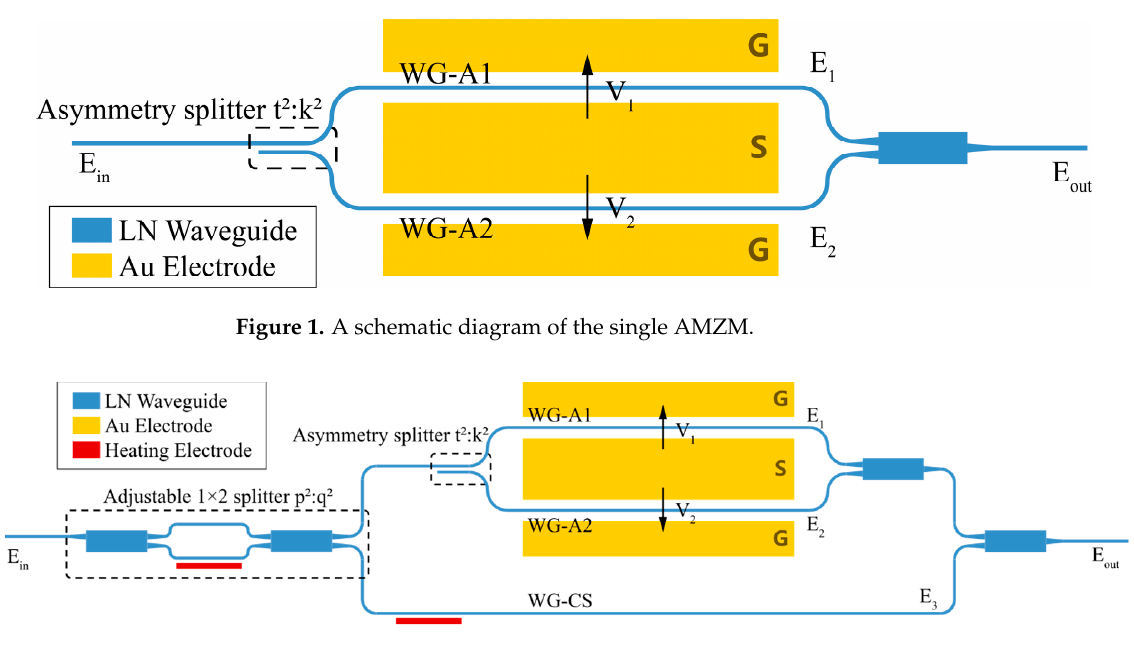
Figure 2. A schematic diagram of the single CS-AMZM.